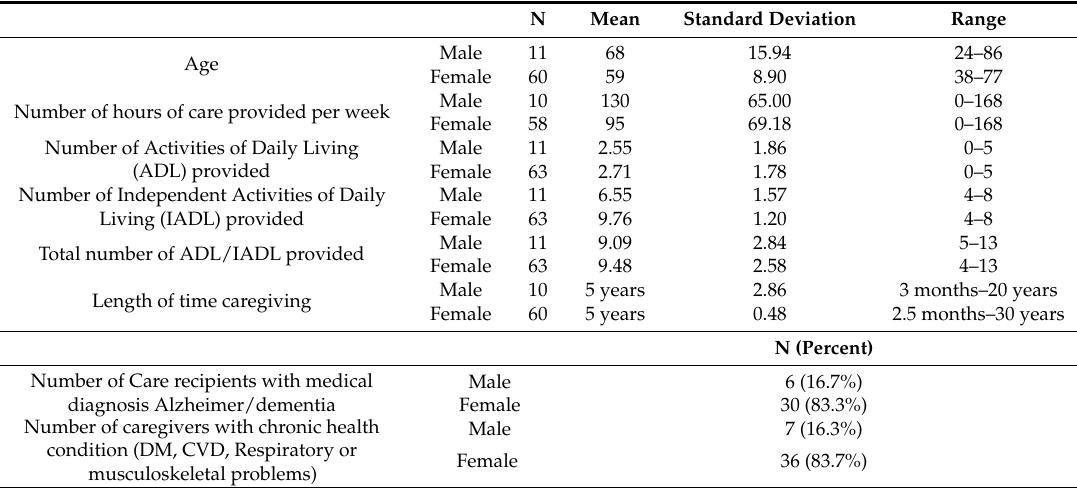
Table 2. Participant characteristics (Time